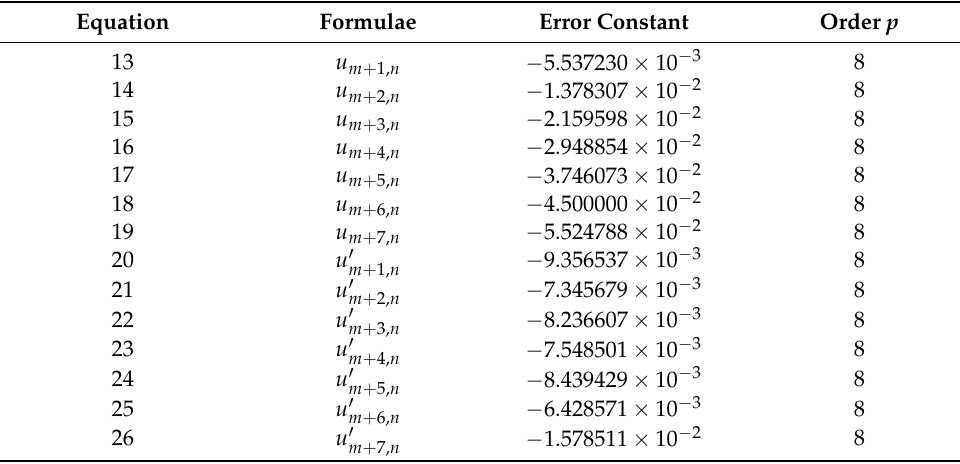
Table 1. Analysis of the order and error constant of HFBI in (13)–(26). Equation Formulae Error Constant Order